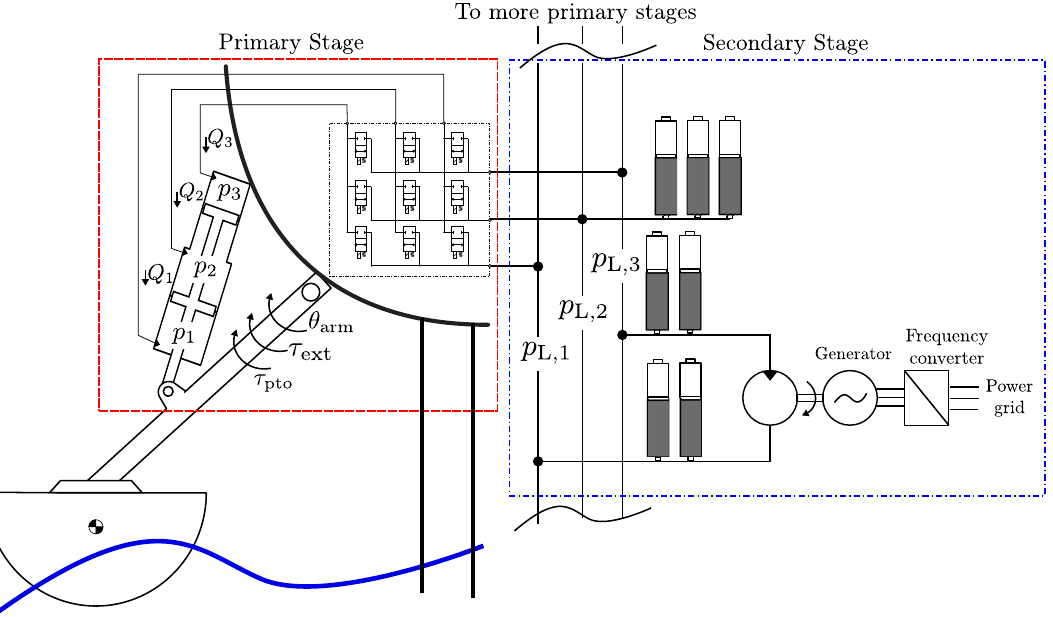
Figure 1. WEC with multiple point absorbers based on a discrete PTO system.